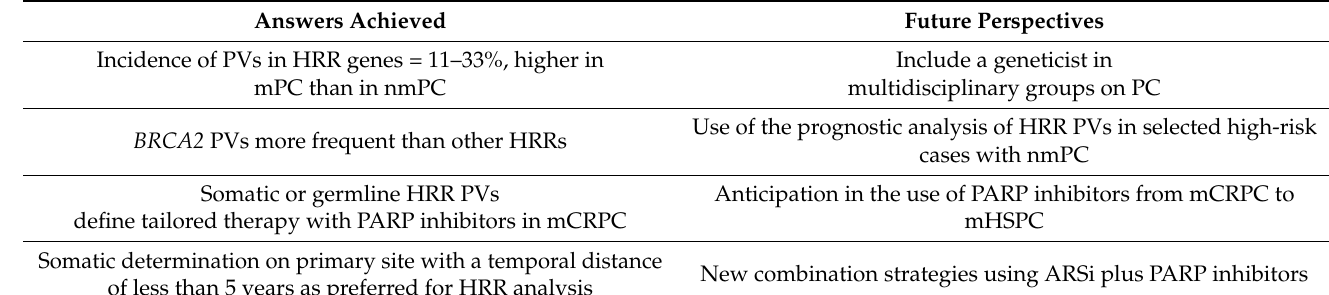
Table 2. Answers achieved and future perspectives regarding DDR gene analysis in prostate cancer. PV, pathogenetic variants; mPC, metastatic prostate cancer; nmPC, non-metastatic prostate cancer; mCRPC, metastatic castration-resistant prostate cancer; HRR, homologous recombination repair; mHSPC, metastatic hormone-sensitive prostate cancer.